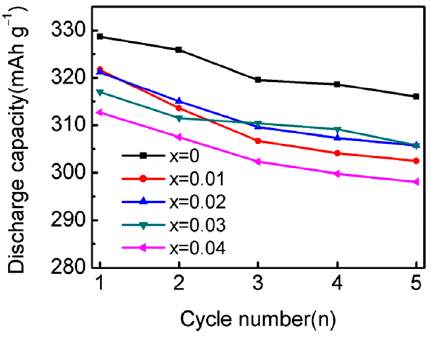
Fig. 6 Activation course the